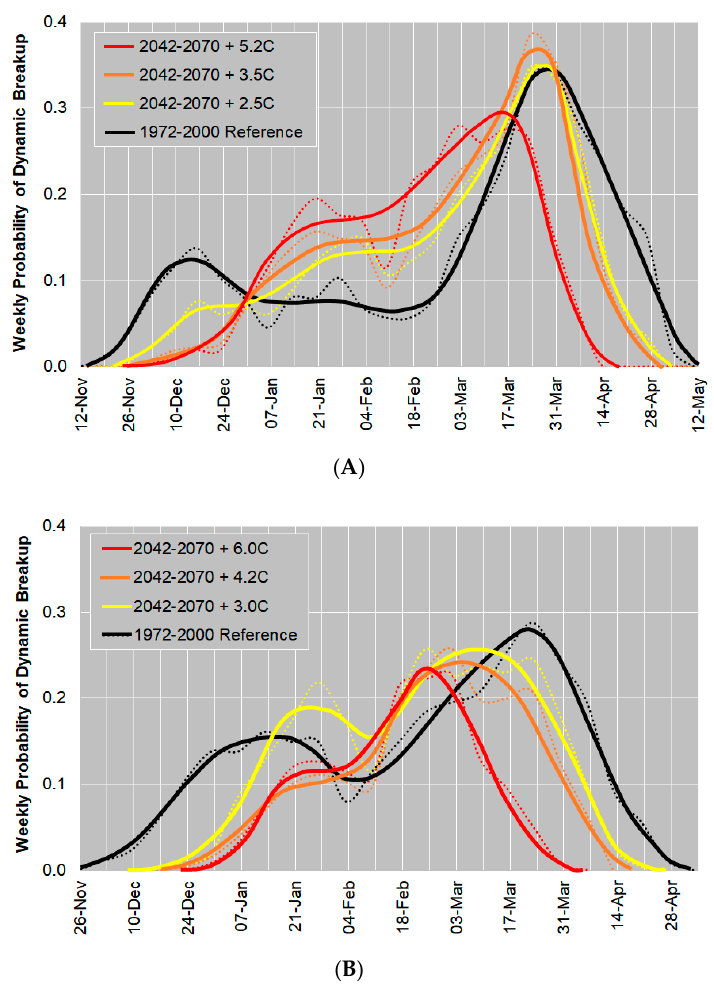
Figure 4. Weekly probability of dynamic breakup events for the reference period (black, 1972–2000) and for different future (2042–2070) climate scenarios for the ( A ) Chaudière and ( B ) Châteauguay Rivers. The dotted lines present the raw data, whereas the thick lines present a smoothened curve, a running average that is adapted for consistent transitions from one scenario to the next.